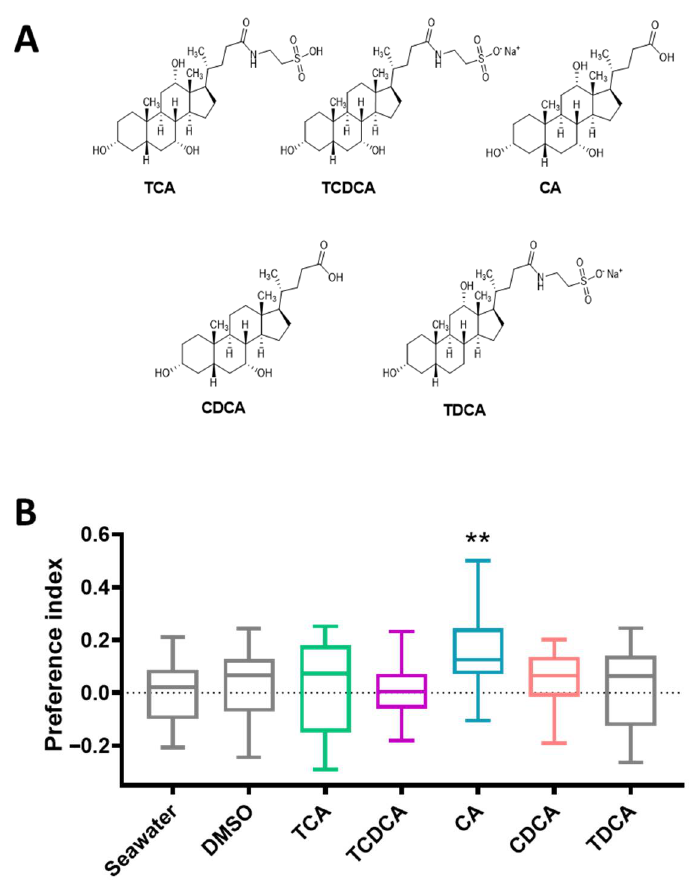
Figure 5. Behavioral responses to the top five BAs of ICs. ( A ) Structures of the top five BAs of ICs. ( B ) The preference index of 10 − 8 mol/L BAs is presented as the mean ± S.E.M.; n = 20. Student’s t -test was used to analyze all data versus DMSO data. ** p < 0.01.